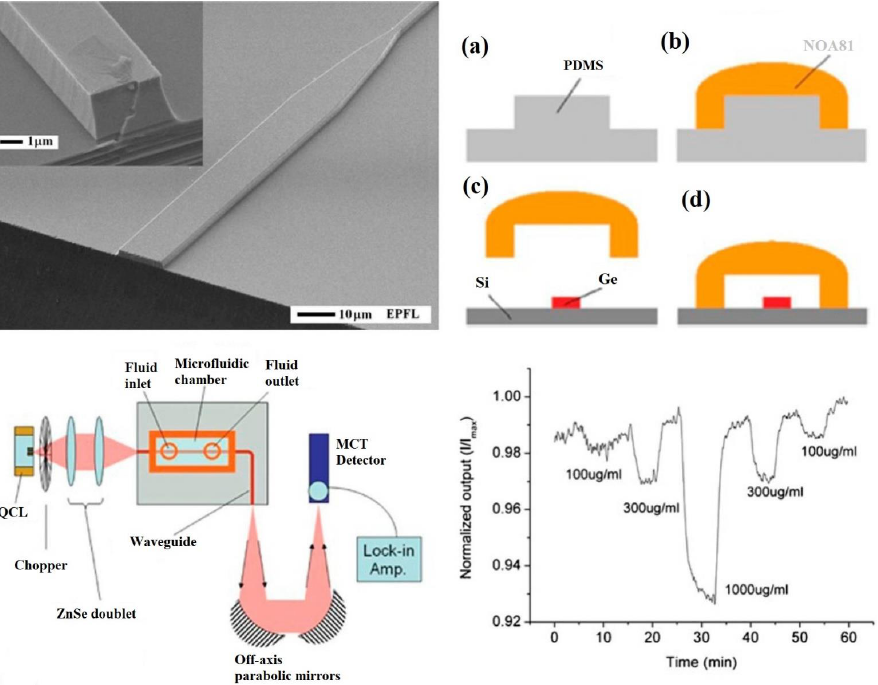
Figure 8. ( top left ) SEM image of a 2- µ m monocrystalline germanium-on-silicon ridge waveguide. ( top right ) Fabrication scheme: a UV-curable adhesive (NOA81) cast onto a PDMS master and subsequently bonded onto the silicon substrate, forming a microfluidic channel, which was connected to a syringe pump. ( bottom left ) Optical setup: QCL radiation is coupled via lenses into the waveguide and via an off-axis parabolic mirror onto a MCT detector. ( bottom right ) Waveguide output during a dynamic analytical study using different cocaine concentrations present at the waveguide surface determined at a wavelength of 5.8 μm. Reproduction requires permission from refs. [111] (Copyright 2012 Optical Society of America) and [112] (Copyright 2012 Royal Society of Chemistry).